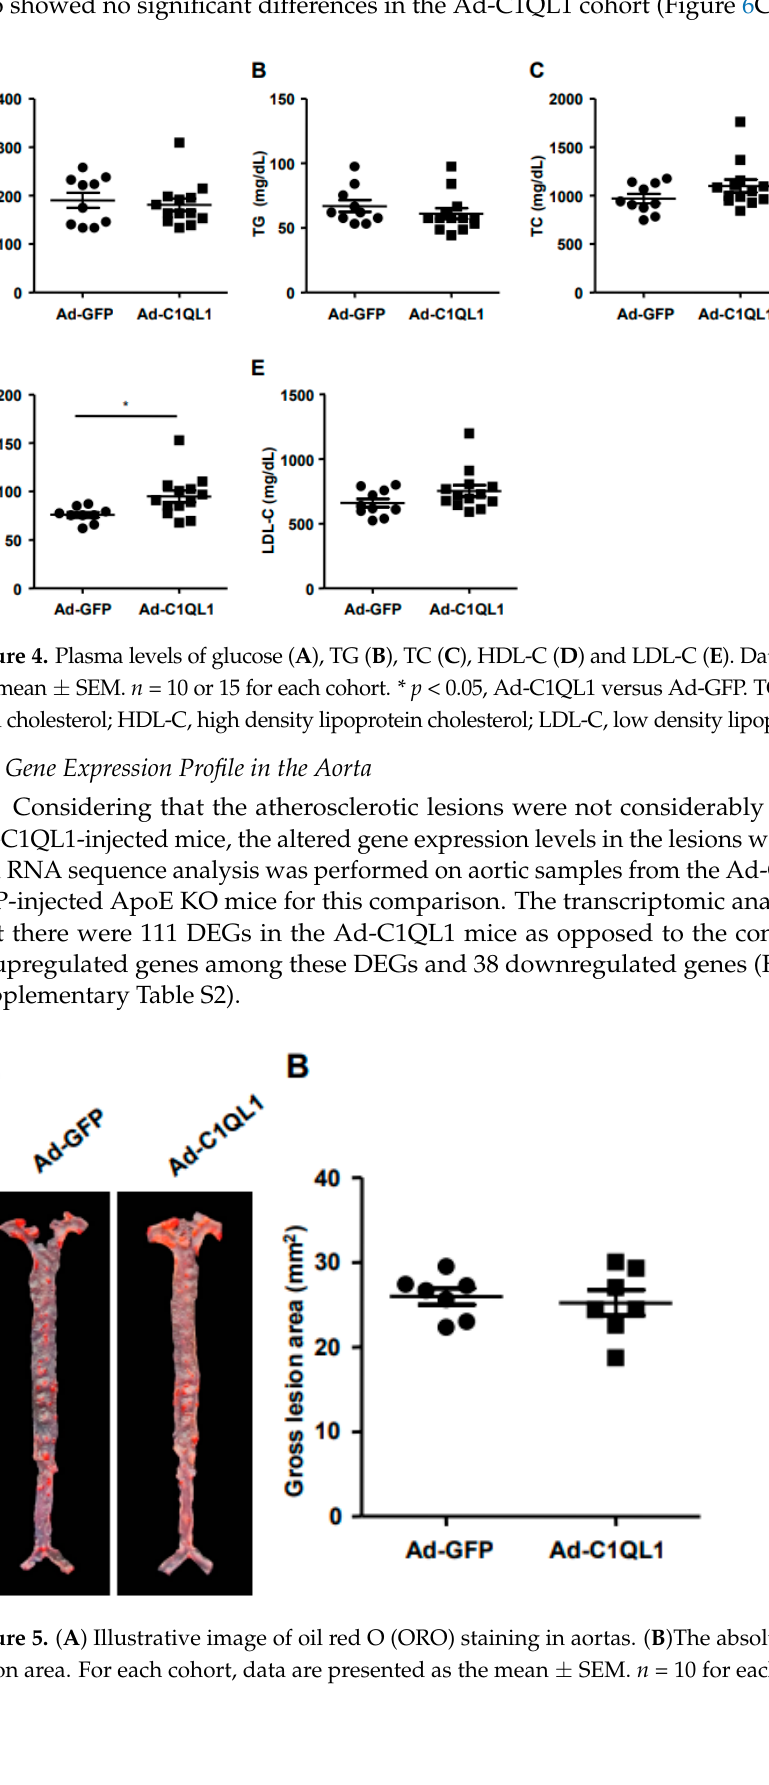
Figure 5. ( A ) Illustrative image of oil red O (ORO) staining in aortas. ( B )The absolute value of gross lesion area. For each cohort, data are presented as the mean ± SEM. n = 10 for each cohort.